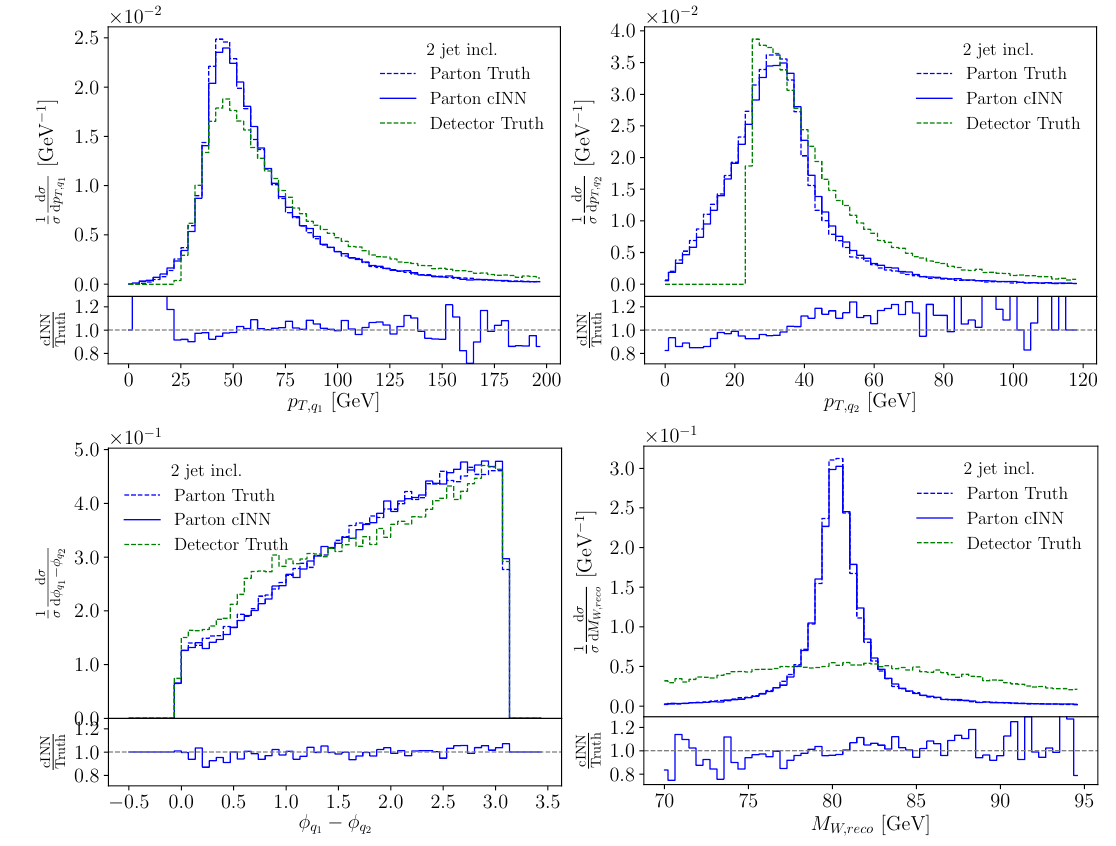
Figure 9: cINNed example distributions. Training and testing events include two to four jets, combining the samples from Fig. 6 and Fig. 8 in one network. At the parton level there exist only two W -decay